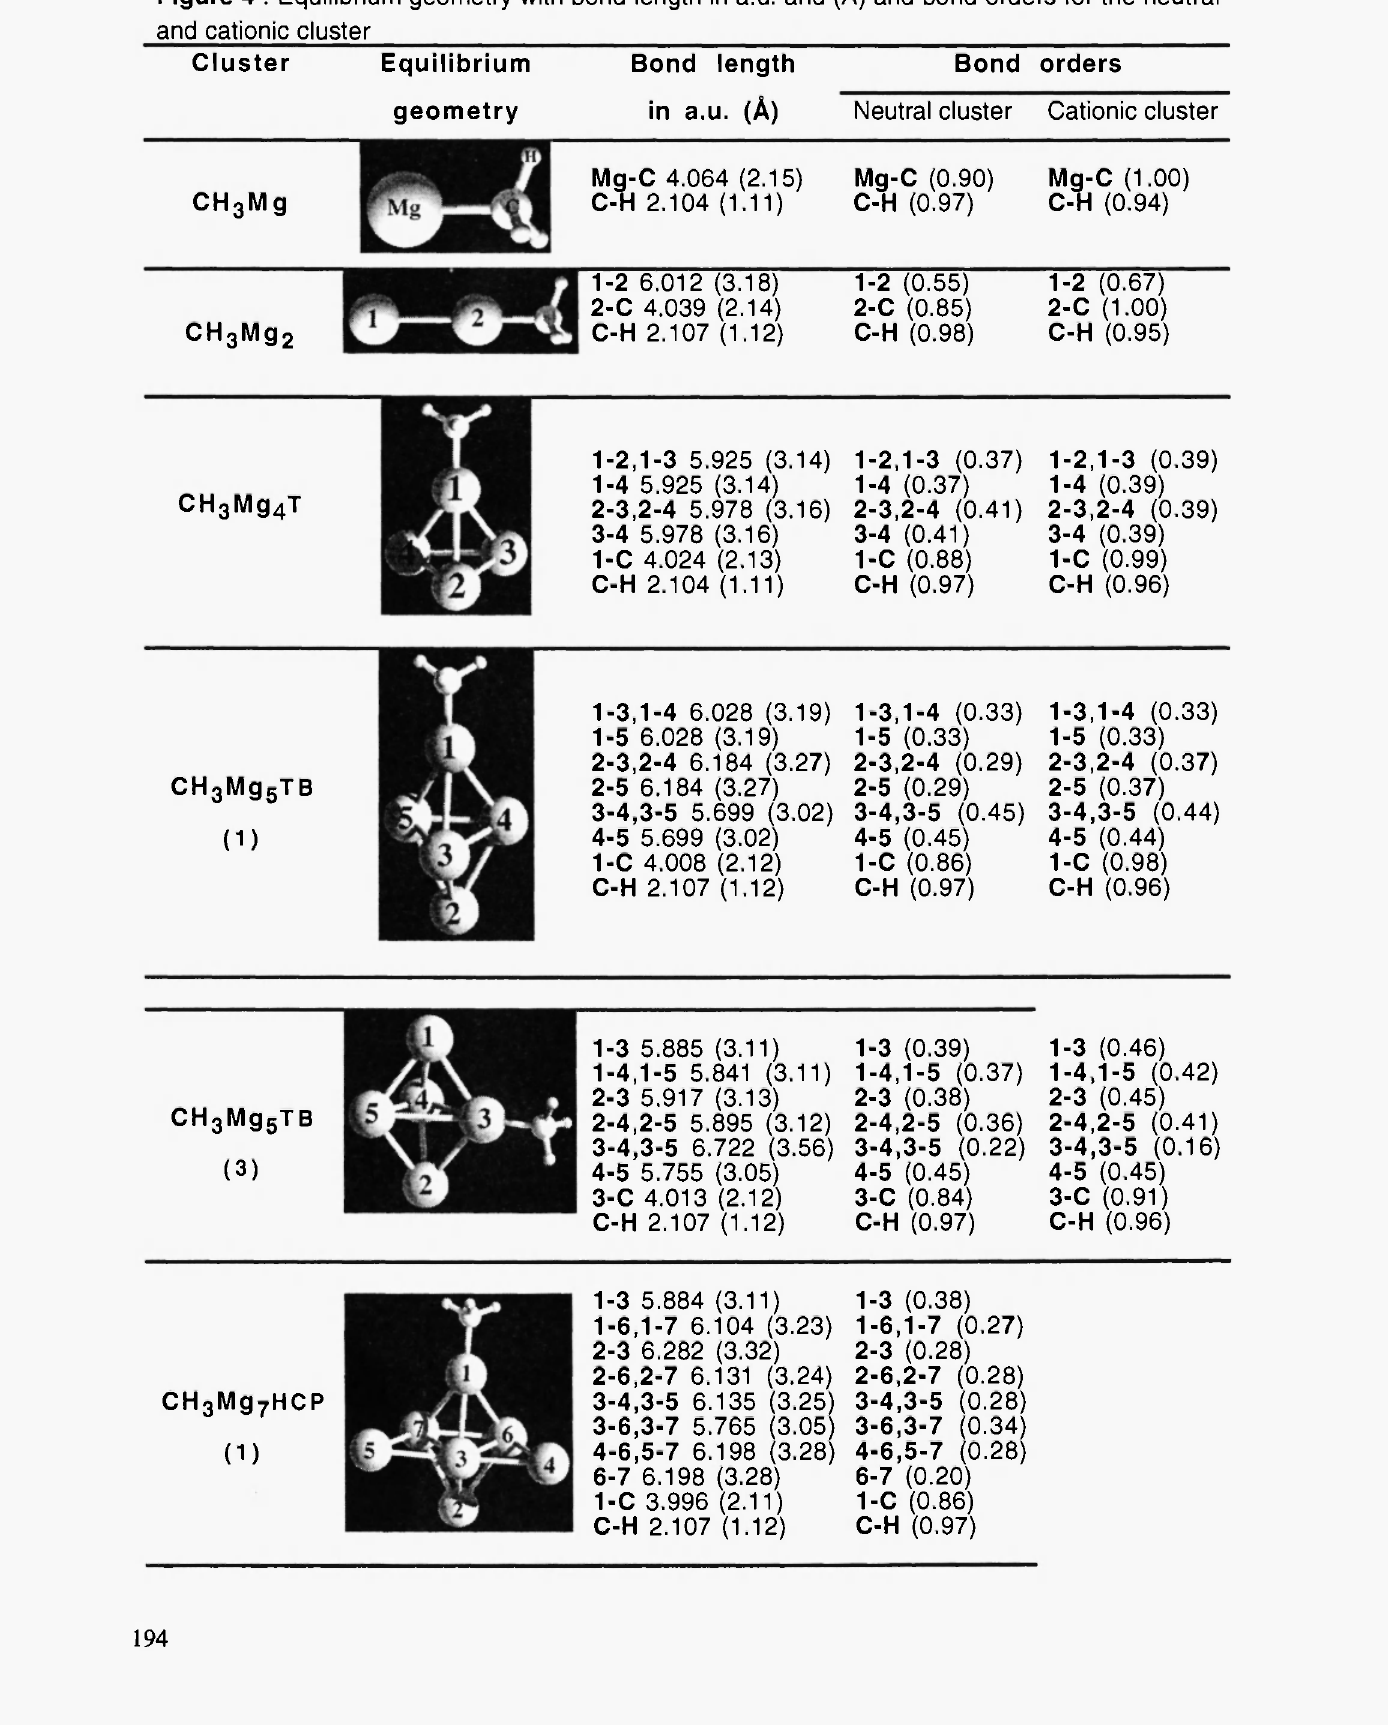
Figure 4 : Equilibrium geometry with bond length in a.u. and (A) and bond orders for the neutral and cationic cluster Cluster Equilibrium Bond length Bond orders geometry in a.u. (Ä) Neutral cluster Cationic cluster Mg-C 4.064 (2.15) Mg-C (0.90) Mg-C (1.00) CH 3 M g C-H 2.104 (1.11) C-H (0.97) C-H (0.94) 1-2 6.012 (3.18) 2-C 4.039 (2.14) C-H 2.107